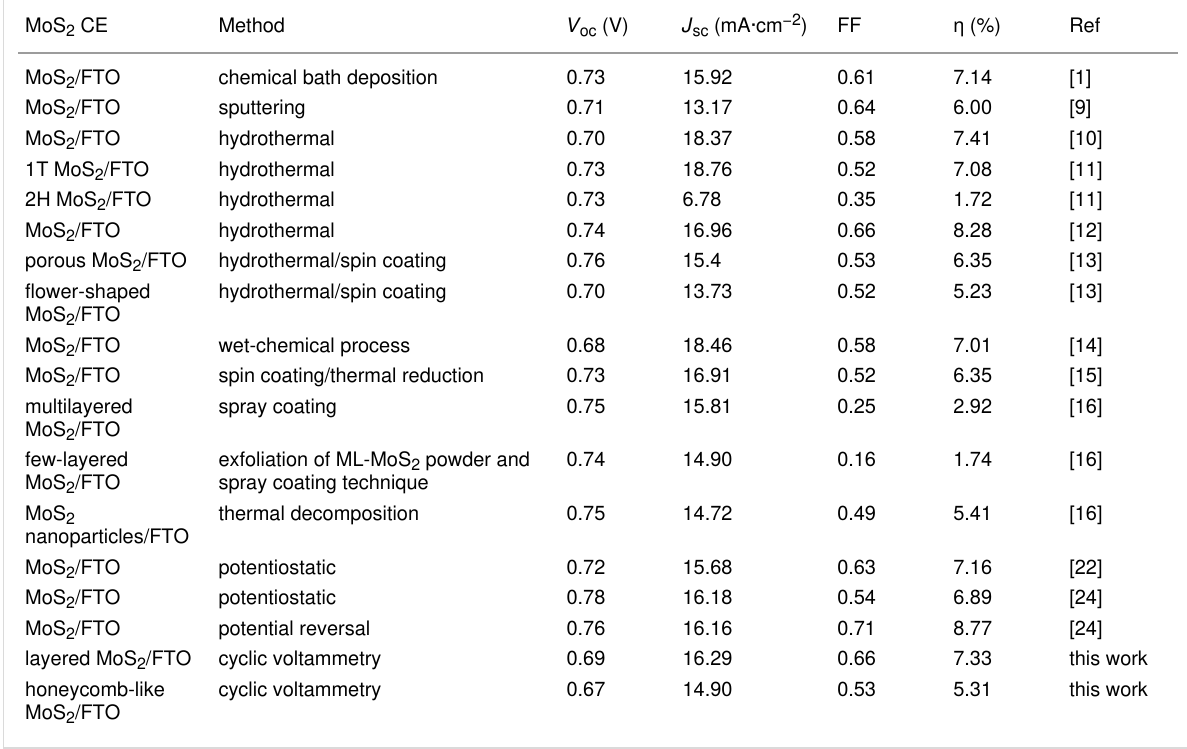
Table 3: Performance summary of MoS 2 -based CEs for DSSCs. MoS 2 CE